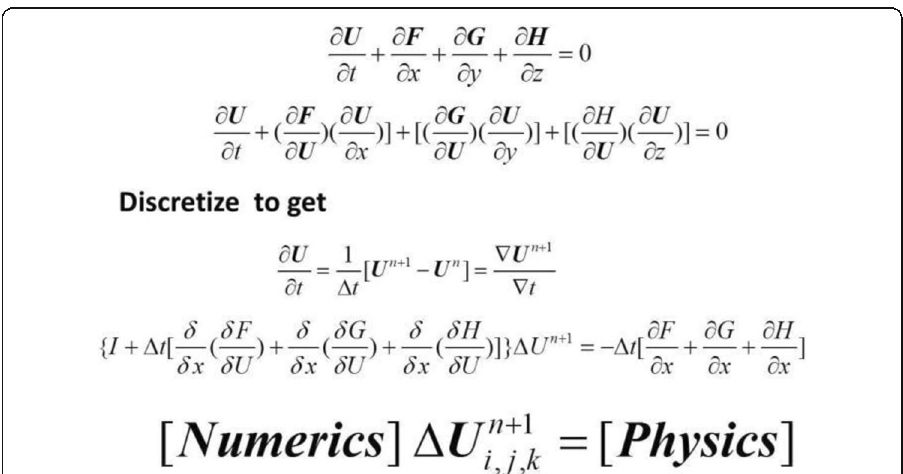
Fig. 2 Relationship between physics fidelity and numerical